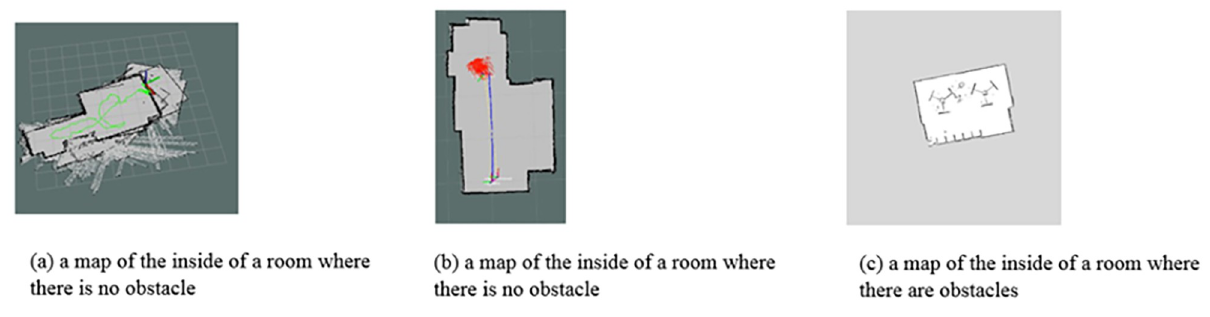
Fig 17. Examples of the maps obtained from the